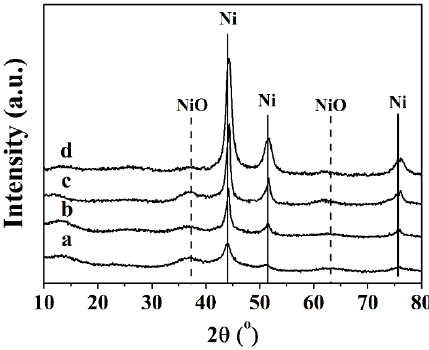
Figure 4. XRD patterns of the calcined catalysts: ( a ) Ni 0.5 MoC–SiO 2 (600); ( b ) Ni 1 MoC–SiO 2 (600); ( c ) Ni 2 MoC–SiO 2 (600); ( d ) Ni 6 MoC–SiO 2 (600).